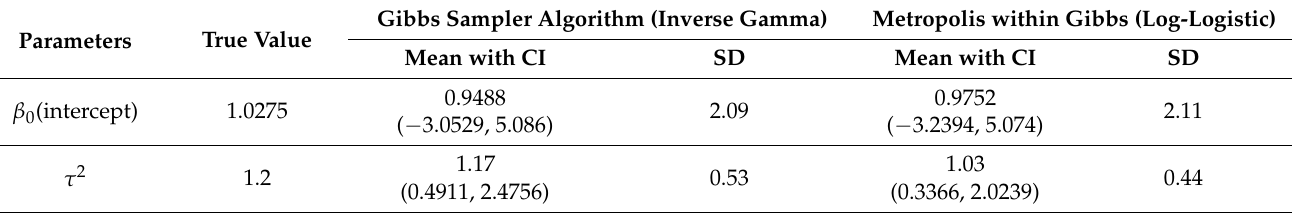
Table 8. Comparison of parameter estimates β 0 (intercept) and τ 2 between the use of the Gibbs sampler algorithm and the Metropolis within Gibbs (simulated data).